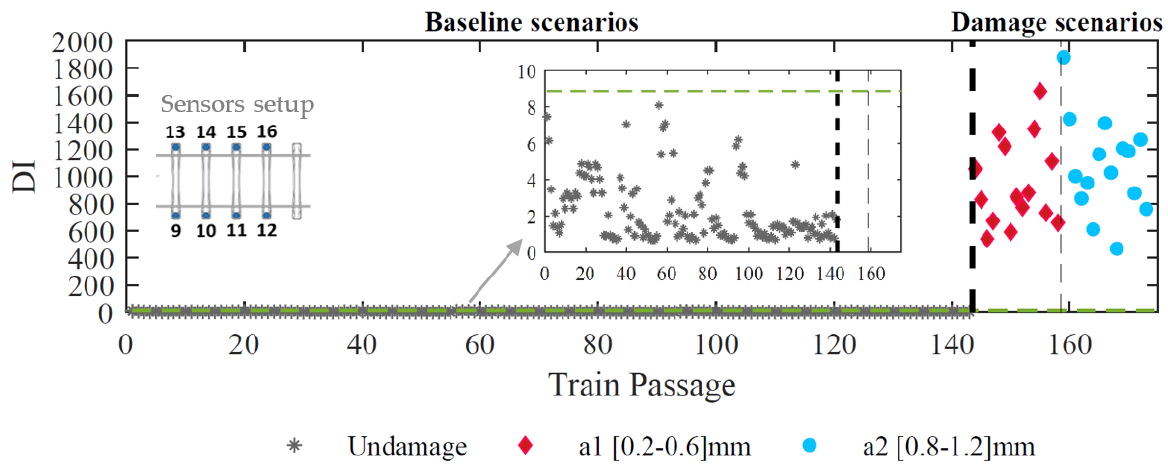
Figure 19. Automatic polygonized wheel detection based on CWT technique considering eight sensors installed on the sleepers.